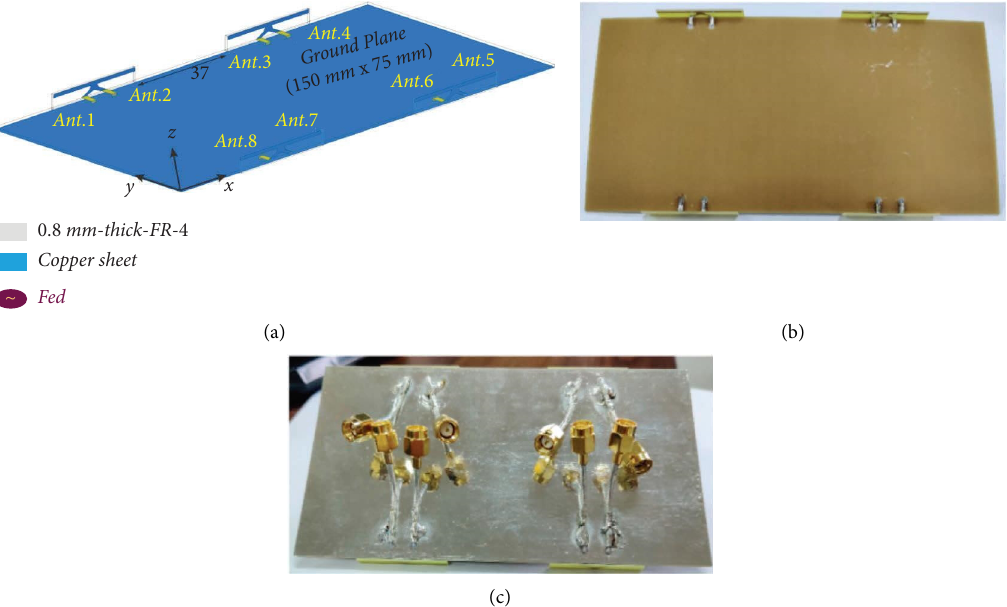
Figure 7: (a) Geometry of the proposed 8 × 8 MIMO antenna. Photographs of the proposed 8 × 8 MIMO antenna are included. (b) Top view. (c) Bottom view (unit: